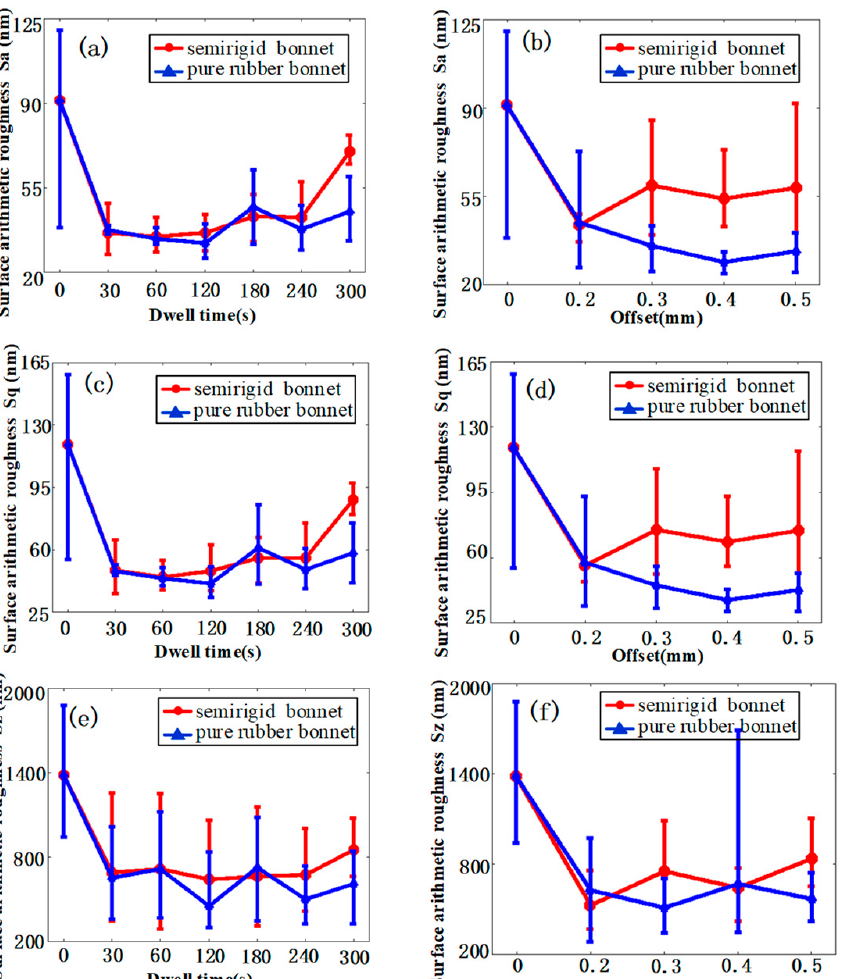
Figure 8. Surface roughness in Sa of the polishing spot of different bonnet tools under ( a ) different dwell times, and ( b ) different offsets by different bonnet tools. Surface roughness in Sq of the polishing spot of different bonnet tools under ( c ) different dwell times, and ( d ) different offsets by different bonnet tools. Surface roughness in Sz of the polishing spot of different bonnet tools under ( e ) different dwell times, and ( f ) different offsets by different bonnet tools.